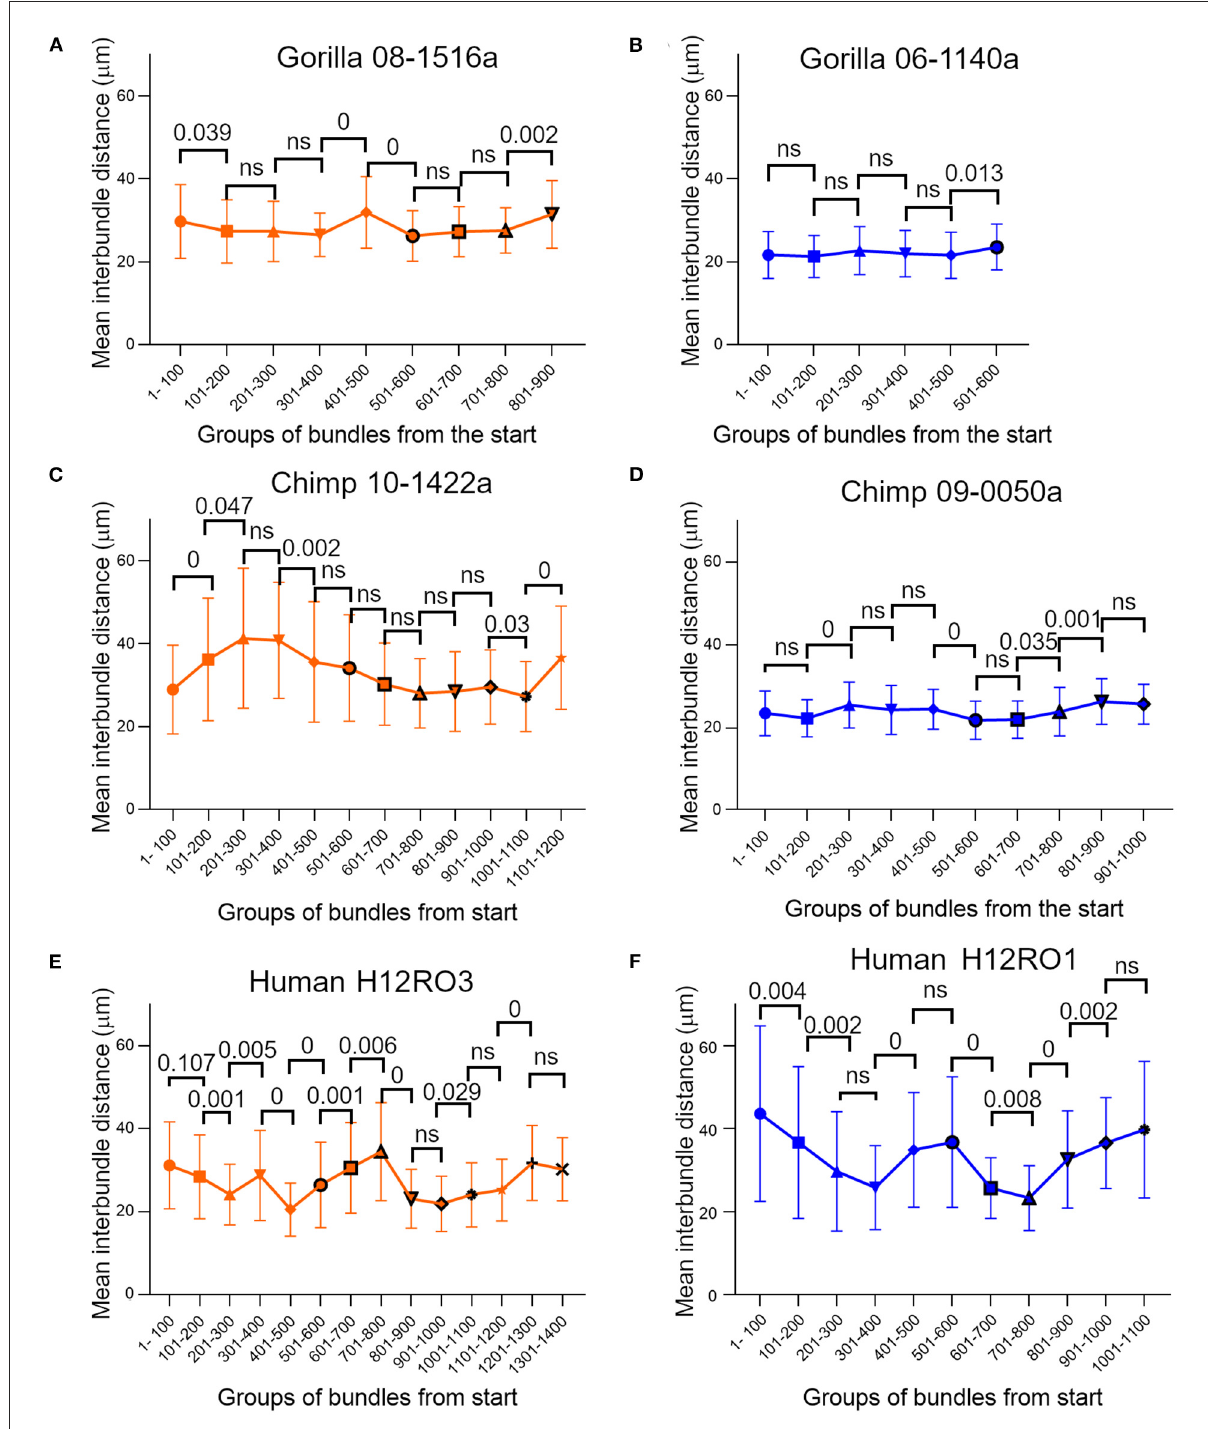
FIGURE6 Plots of mean inter-bundle values based on sequential groups of 100 bundles measured in layer V of orthogonal blocks from human and ape brains where there was at least 10mm of cortical primary visual area containing clear bundles. The error bars indicate the standard deviation for each group. For all three species the mean values were not constant but varied across the cortical surface. Most groups of bundles were not normally distributed and in order to compare the difference between consecutive groups statistically, the median values were compared with a Mann-Whitney test and the probability value plotted above the pairs of means in panels (A, C–F) . For some pairings the medians show no significant (ns) difference at the p = 0.05 level. In panel (B) all the groups of bundles had normally distributed values and so the difference between their sequential mean values were compared with an unpaired t